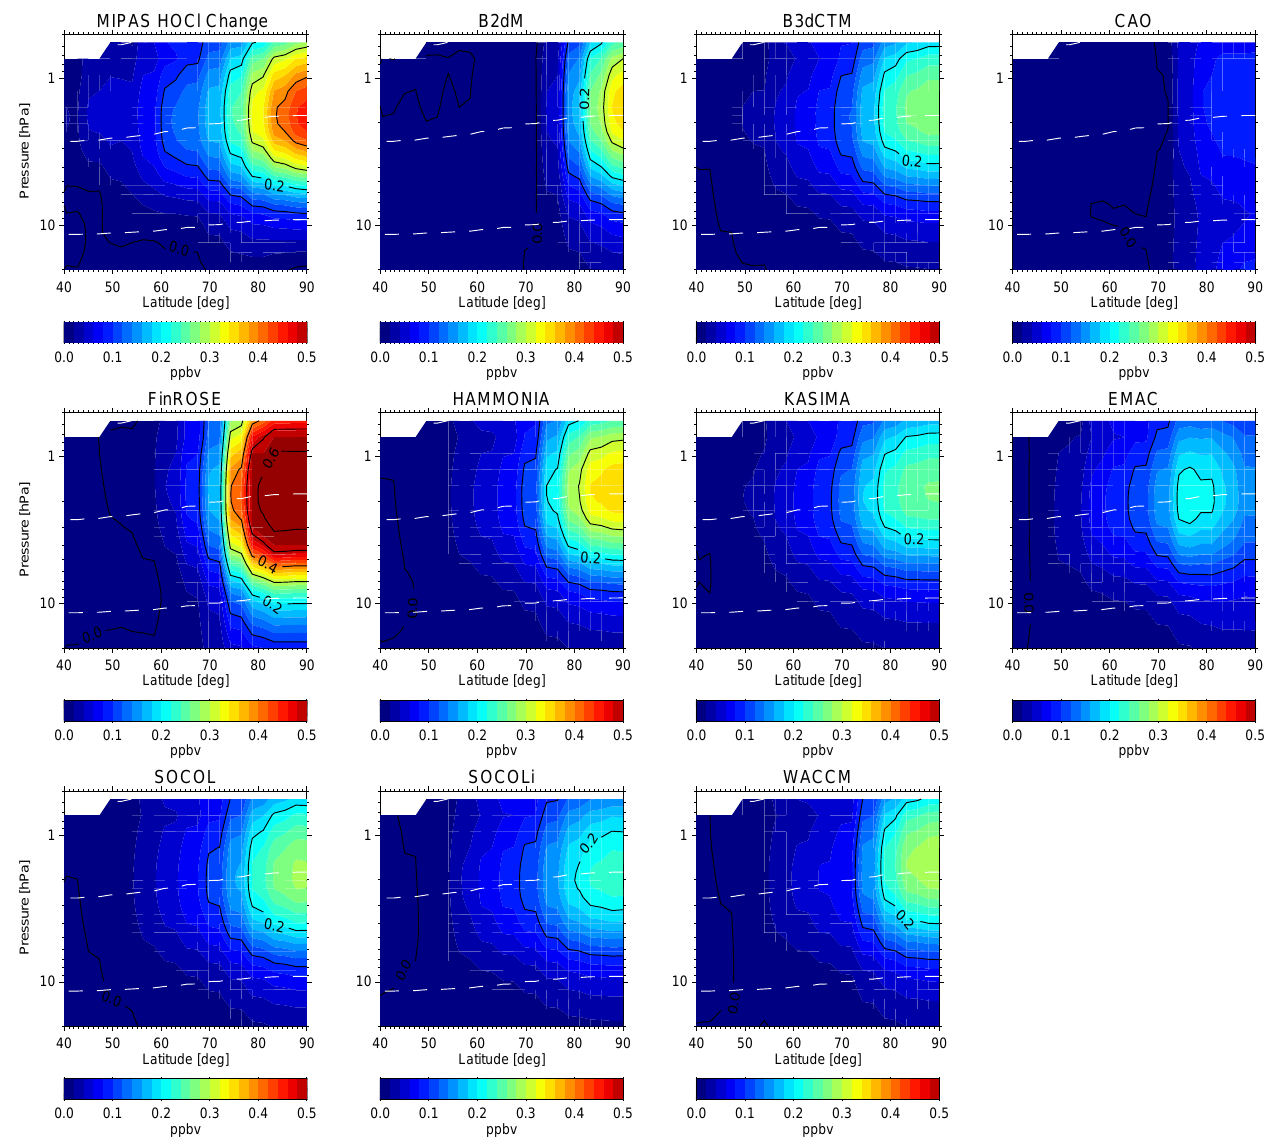
Fig. 35. Zonal mean HOCl changes during the main proton forcing (29–31 October) with respect to 26–27 October in MIPAS observations and model simulations. Solid contour lines reflect 0.1 ppbv steps.